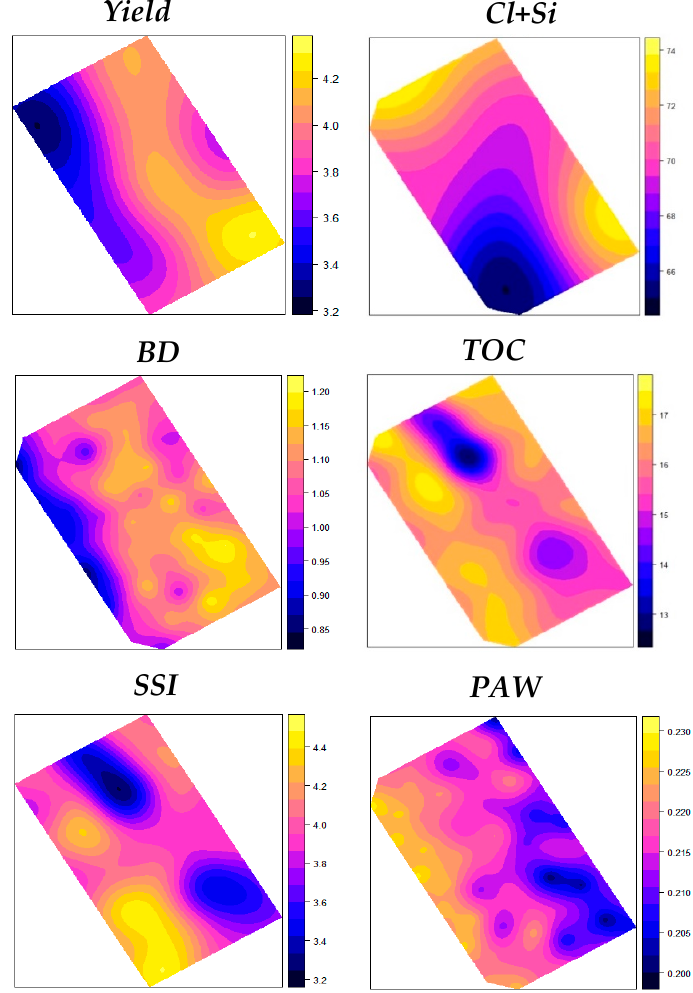
Figure 5. Spatial estimates of wheat yield (t ha − 1 ), clay and silt content Cl + Si (%), dry bulk density, BD (g cm − 3 ), soil total organic carbon, TOC (g kg − 1 ), structure stability index, SSI (%) and plant available water capacity, PAWCe (cm 3 cm − 3 ).